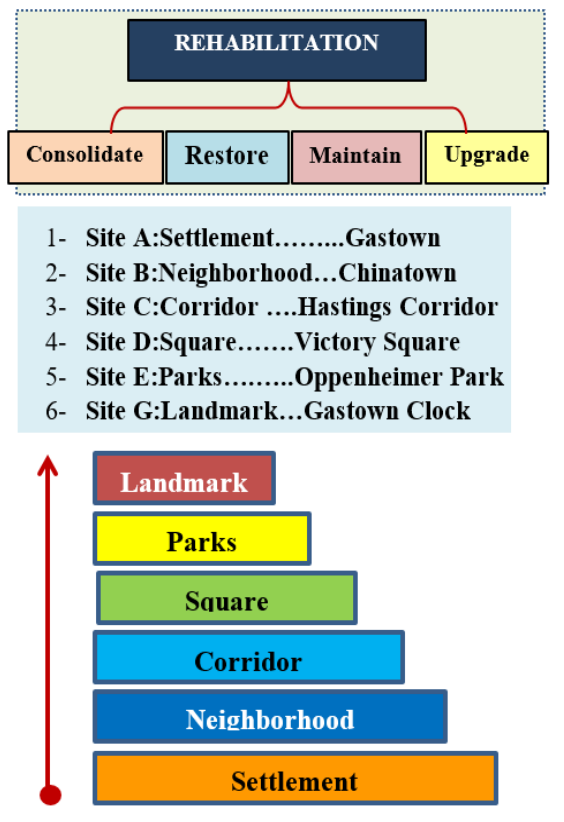
Figure 2. Levels of urban hierarchy that applied the program of heritage and rehabilitation. Source: The